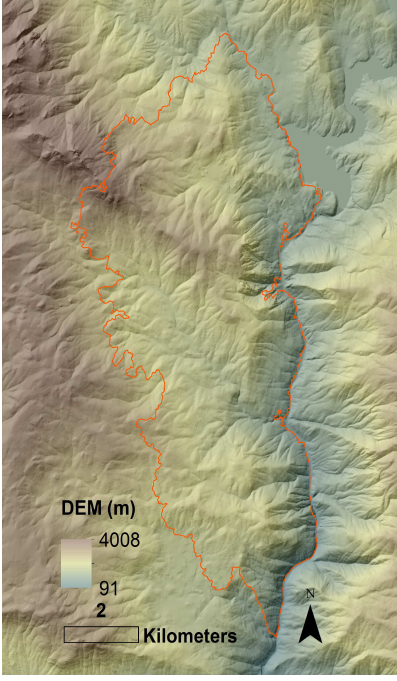
Figure 2. Example 30m DEM downloaded after the French Fire soil burn severity map was uploaded into the database.